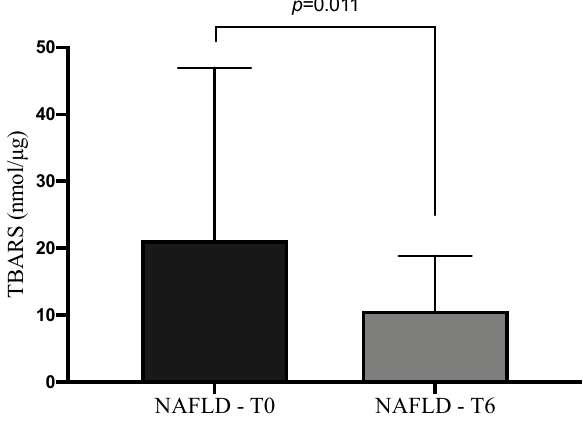
Figure 4. Thiobarbituric acid reactive substances (TBARS), levels at baseline and after six months of silybin with phospholipids and vitamin D (RealSIL 100D) administration ( p = 0.011).